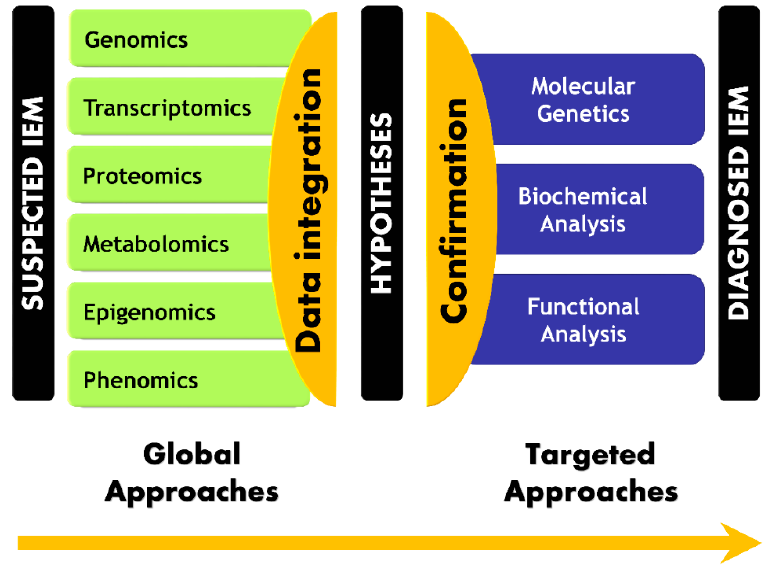
Figure 6. Paradigm shift in Inborn Errors of Metabolism (IEM) diagnosis workflow. Laboratory workflow using high-throughput analytical technologies, integrative bioinformatics, and computational frameworks recovers molecular information for more effective medical decision-making.